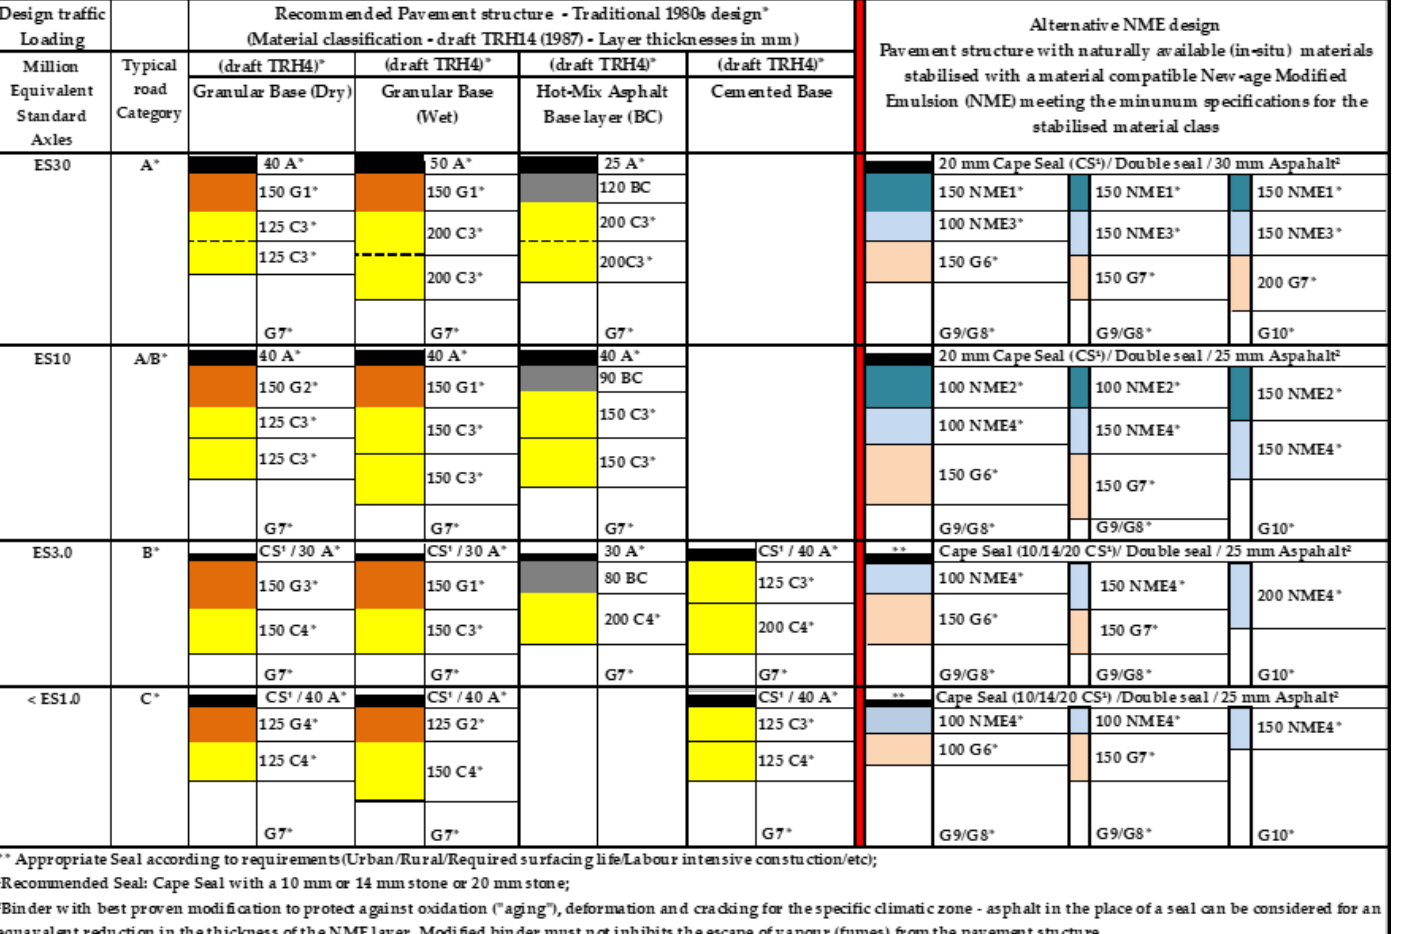
Figure 2. References [6,7]: Comparative pavement designs based on high-quality crushed +/or cement-treated materials with relatively thin surfacings and the newly recommended NME-stabilised designs using naturally available materials. (* Typical examples of recommended pavement structures taken from the draft TRH4 [22] with material classification according to TRH14 [23] (A = Asphalt; CS = Chip-seal; C = Cement stabilisation; G = Granular materials (Figure 1); NME = New-age Modified Emulsions (Figures 3 and 4)).